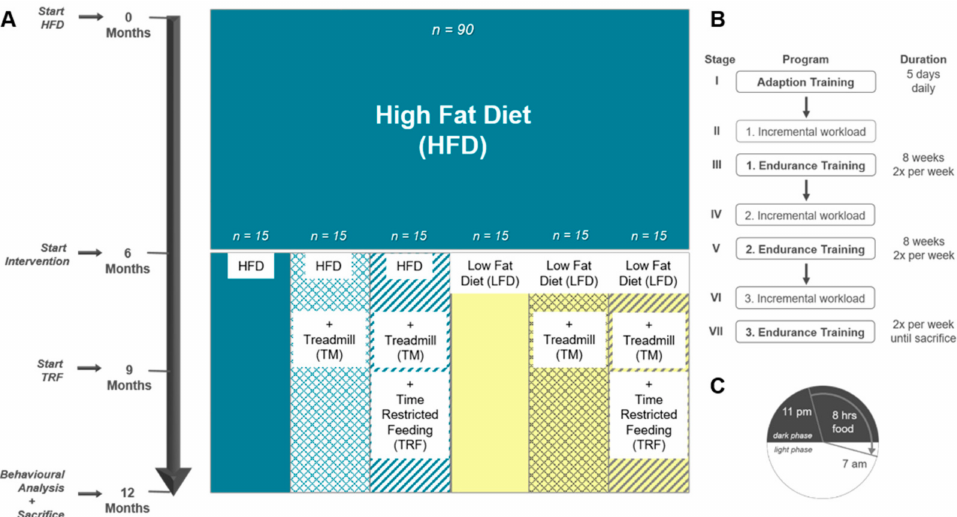
Figure 2. ( A ) Experimental design. A: Female C57BL/6J mice ( n = 90) were fed 6 months on high-fat diet (HFD) to establish the model of DIO. Thereafter, mice were divided into 6 groups. The first group remained on HFD ( n = 90). Groups two to six underwent an intervention. Second group: